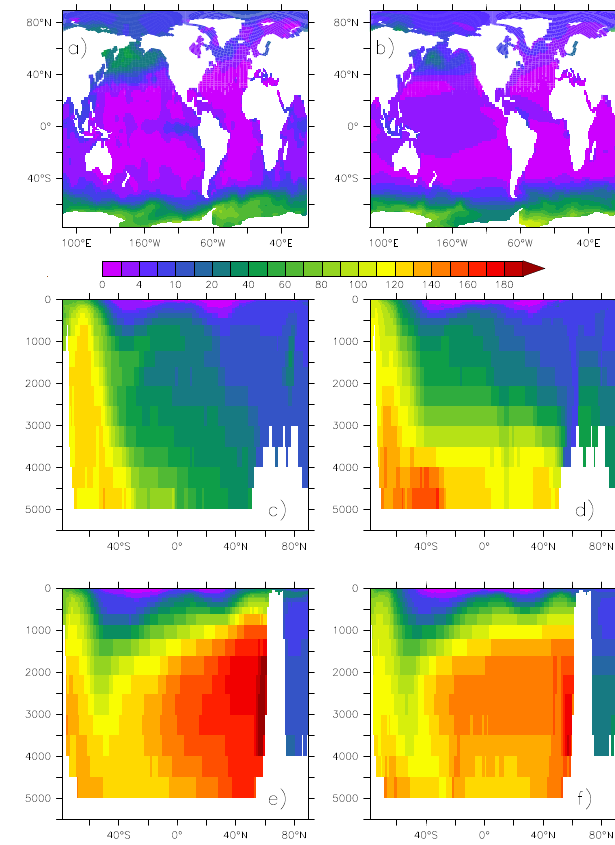
Figure 10. Annual-mean SiO 3 concentrations in µmolSiL − 1 . Ob- servations are from the World Ocean Atlas 2009 (Garcia et al., 2010). Panels are the same as on Fig.